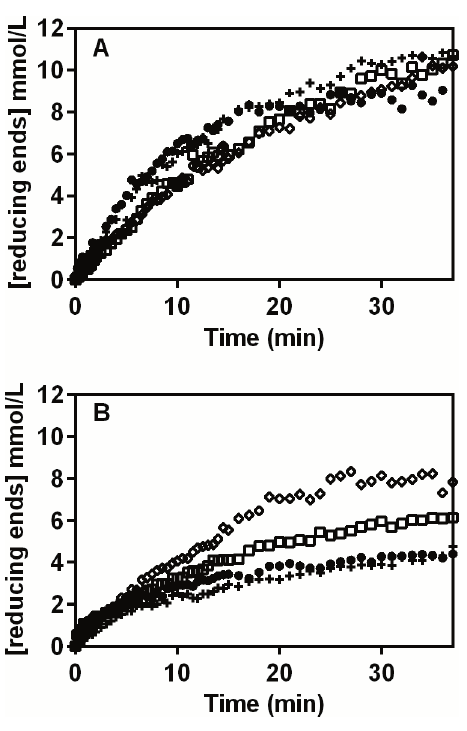
Figure 6. Extended hydrolysis profiles (24 h), obtained using different pectinase complexes and either polygalacturonic acid (A) or citric pectin (B). The hydrolysis was performed at 40 u C, N with an initial substrate concentration of 0.5% (w/v). The pectinase ) and complexes used were the extracts of Aspergillus niger ( Aspergillus oryzae ( + ), produced in solid-state fermentation, and the commercially available Pectinex Ultra SPL (Novozymes) ( % ) and Pectinase P4716 (Sigma-Aldrich) ( e ).